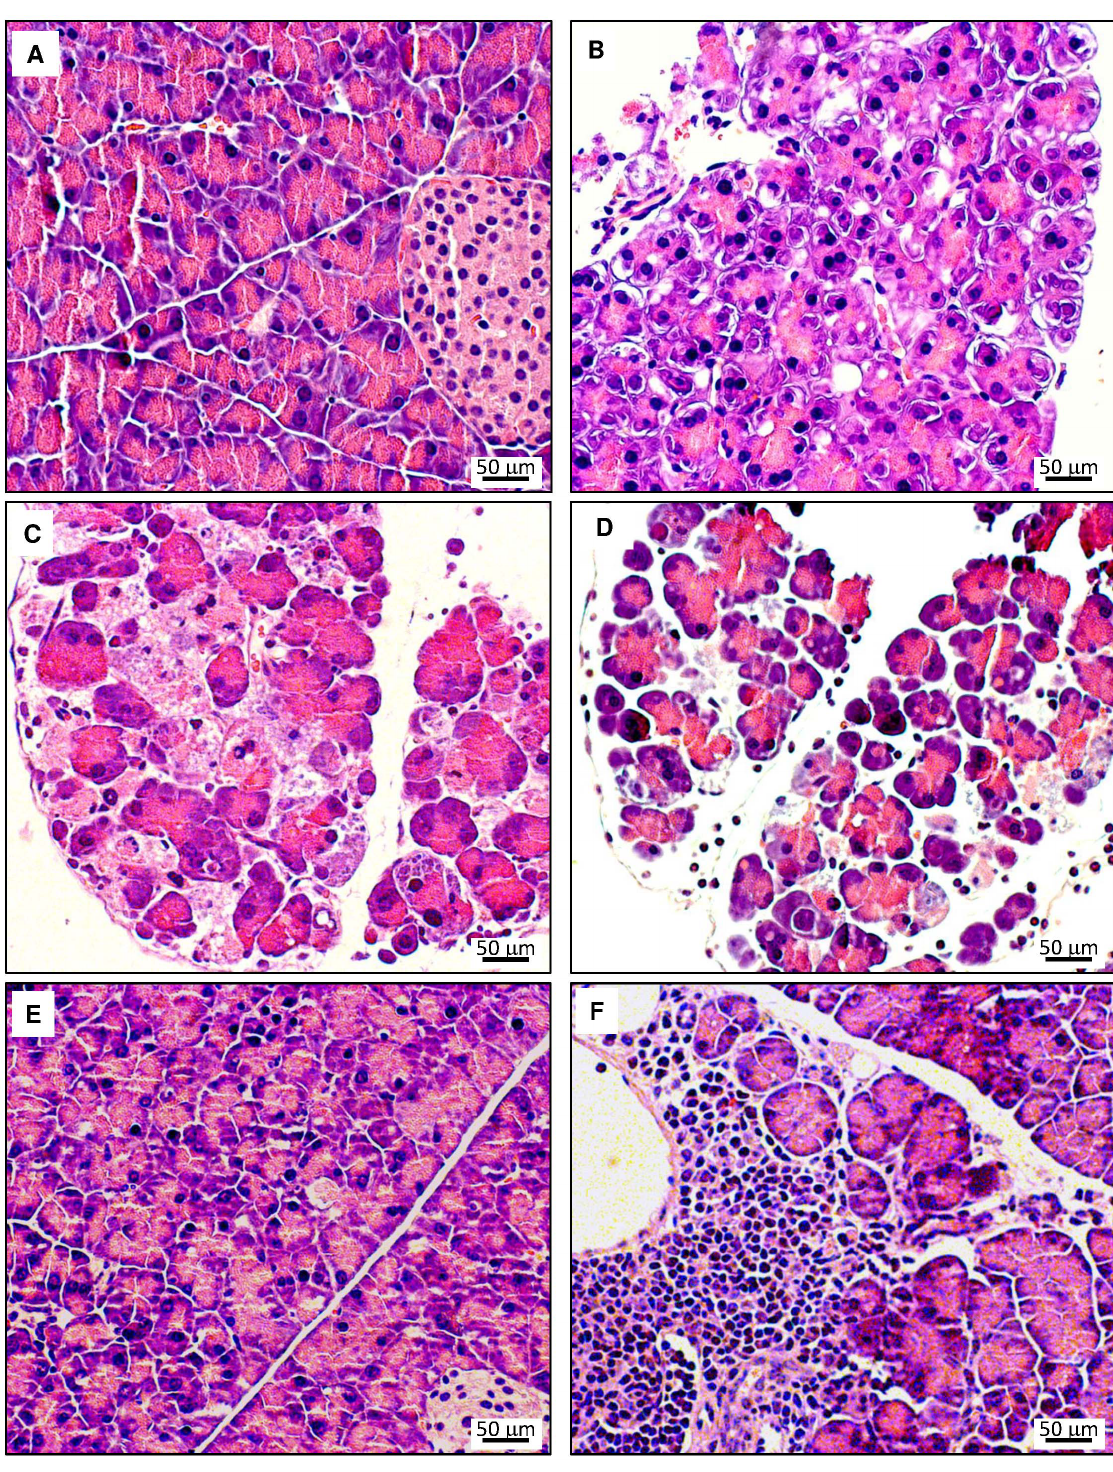
Figure 3. Histopathology of pancreatic lesions in cerulein-treated 12 months old WT C57BL/6 mice. Pancreatic sections were stained with H&E. Photographs A–E display representative examples of pancreatic damage at the time points 0 h, 3 h, 8 h, 24 h and 7 days after the start of cerulein treatment. (A) 0 h – healthy pancreas (B) 3 h – focal cell swelling, vacuolization and cystic degeneration, death of single cells (C) 8 h – in addition to the changes at 3 h progressive interstitial edema and widespread cell death (D) 24 h – interstitial edema, cell degeneration and multiple apoptotic and necrotic cells; presence of interstitial inflammatory cells (E) day 7 – slight residual cell swelling. Photograph (F) from a mouse on day 7 shows an additional incidental finding occasionally observed especially in 12 months old mice: lymphoplasmacytic and eosinophilic interstitial infiltrate surrounding ducts and vessels; compatible with an autoimmune pancreatitis.